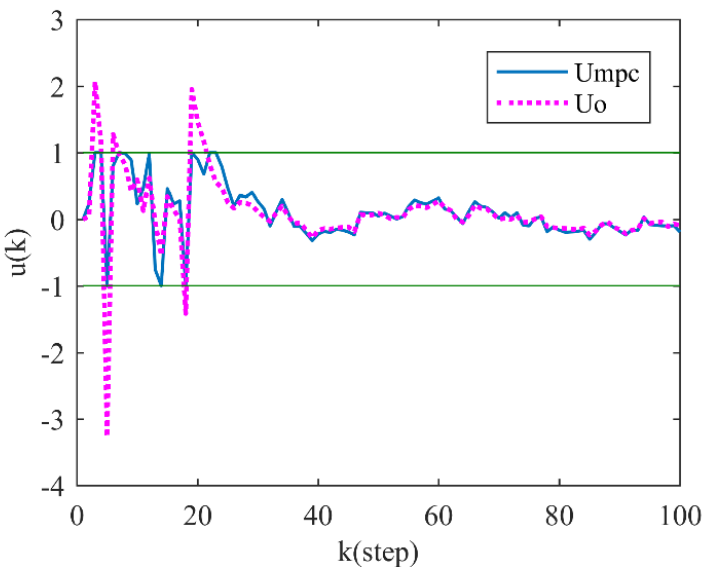
Figure 4. Comparison of optimal MPC and learning MPC control signals when parameters are